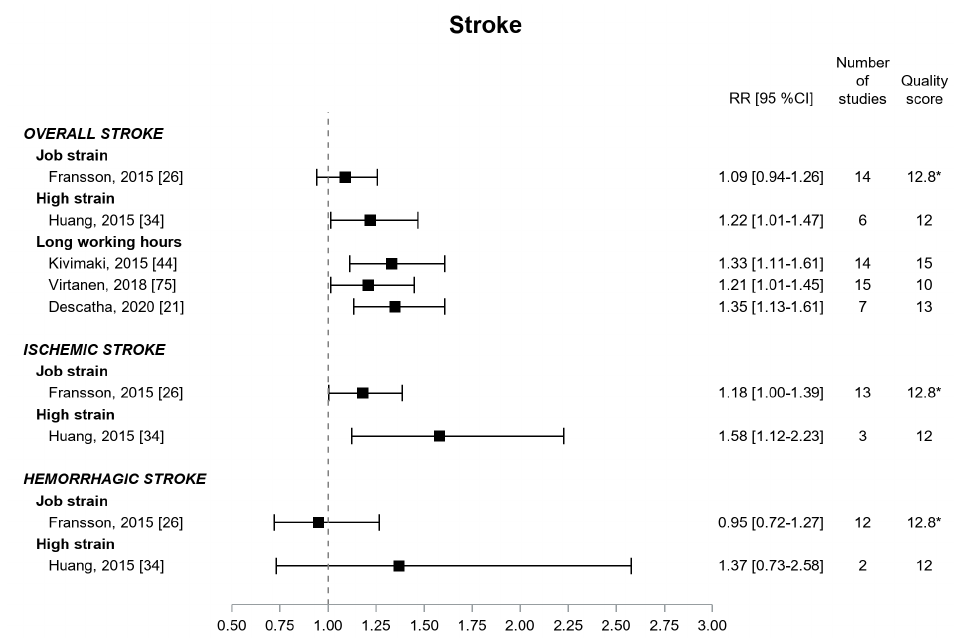
Figure 3. Pooled estimates for the associations between psychosocial work exposures and stroke. * IPD-Work Consortium studies without systematic literature